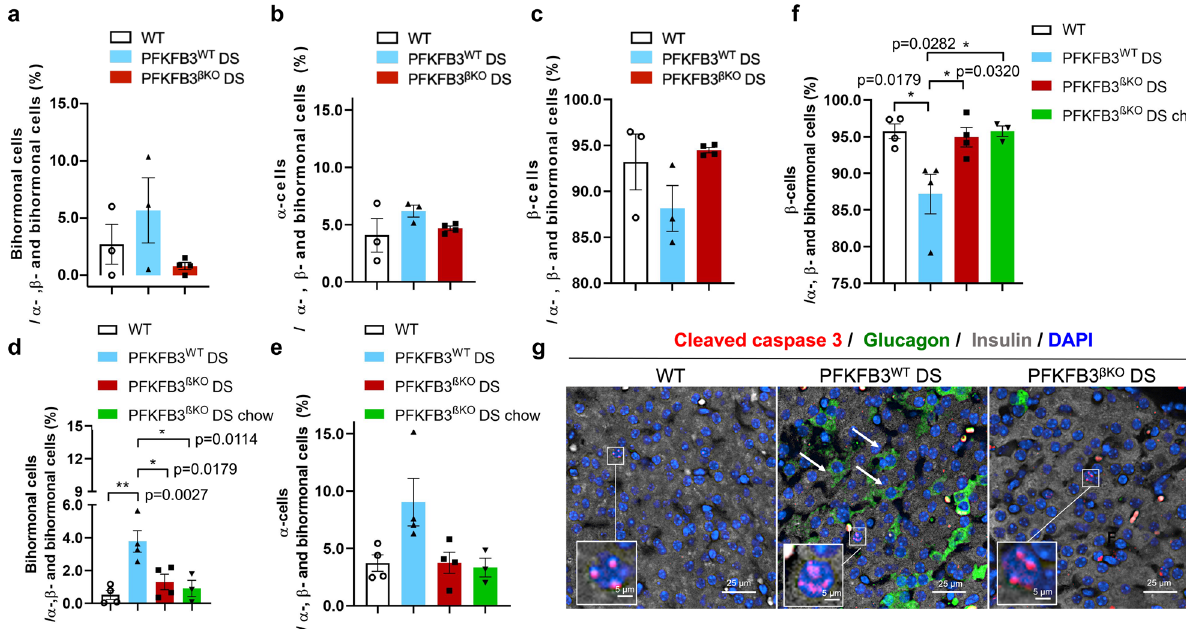
Fig. 7 PFKFB3 β KO DS mice show a decrease of double- insulin and glucagon positive cells at lower and higher diabetogenic stress. a Quanti fi cation of the ratio between bihormonal (insulin- and glucagon positive) cells relative to all α -, β - and bihormonal cells (%) at 13 weeks of HFD. b Quanti fi cation of the ratio between α -cells relative to all α -, β - and bihormonal cells (%) at 13 weeks of HFD. c Quanti fi cation of the ratio between β -cells relative to all α -, β - and bihormonal cells (%) at 13 weeks of HFD. d Quanti fi cation of the ratio between bihormonal (insulin- and glucagon positive) cells relative to all α -, β - and bihormonal cells (%) at 8 weeks HFD (** p = 0.0027, * p = 0.0179, * p = 0.0114, n = 4 independent animals, SEM). e Quanti fi cation of the ratio between α -cells relative to all α -, β - and bihormonal cells (%) at 8 weeks of HFD. f Quanti fi cation of the ratio between β -cells relative to all α -, β - and bihormonal cells (%) at 8 weeks of HFD (* p = 0.0179, * p = 0.0320, * p = 0.0282, n = 4 independent animals, SEM). g Representative immuno fl uorescence images of islets from WT, PFKFB3 WT DS and PFKFB3 β KO DS mice at 13 weeks of HFD co-immunostained for cleaved caspase-3 (red), insulin (grey), glucagon (green) and nuclei (blue).